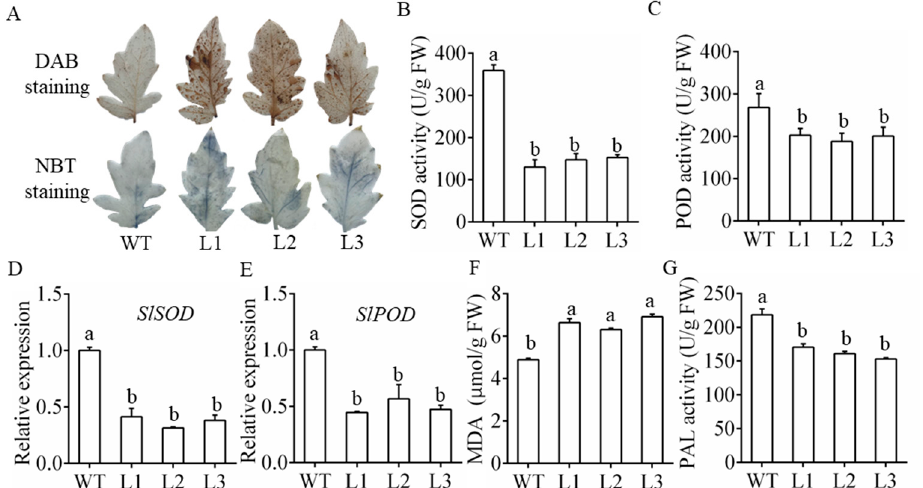
Figure 4. Detection of physiological and biochemical indicators of the miR482c-overexpression plants. ( A ) Diamino benzidine (DAB) staining and nitro blue tetrazolium (NBT) staining of tomato leaves in the whole-plant infection assay on the 5th day after infection. ( B , C ) SOD ( B ) and POD ( C ) activity of WT and L1–L3 after infection for 5 days. ( D , E ) The expression levels of SlSOD ( D ) and SlPOD ( E ) in WT and transgenic lines on the 5th day after infection. ( F ) The malondialdehyde (MDA) content of WT and L1–L3 after infection for 5 days. ( G ) The phenylalanine ammonia-lyase (PAL) activity of WT and L1–L3 after infection for 5 days. SDs of three replicates are indicated with error bars. The letters above the column indicate a significant difference ( p < 0.05) between the samples.